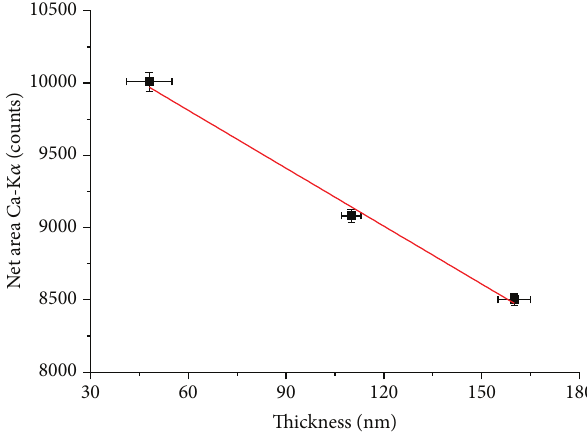
Figure 7: Calibration curve for net area of K 𝛼 line of calcium (Ca) versus thickness of vanadium determined by